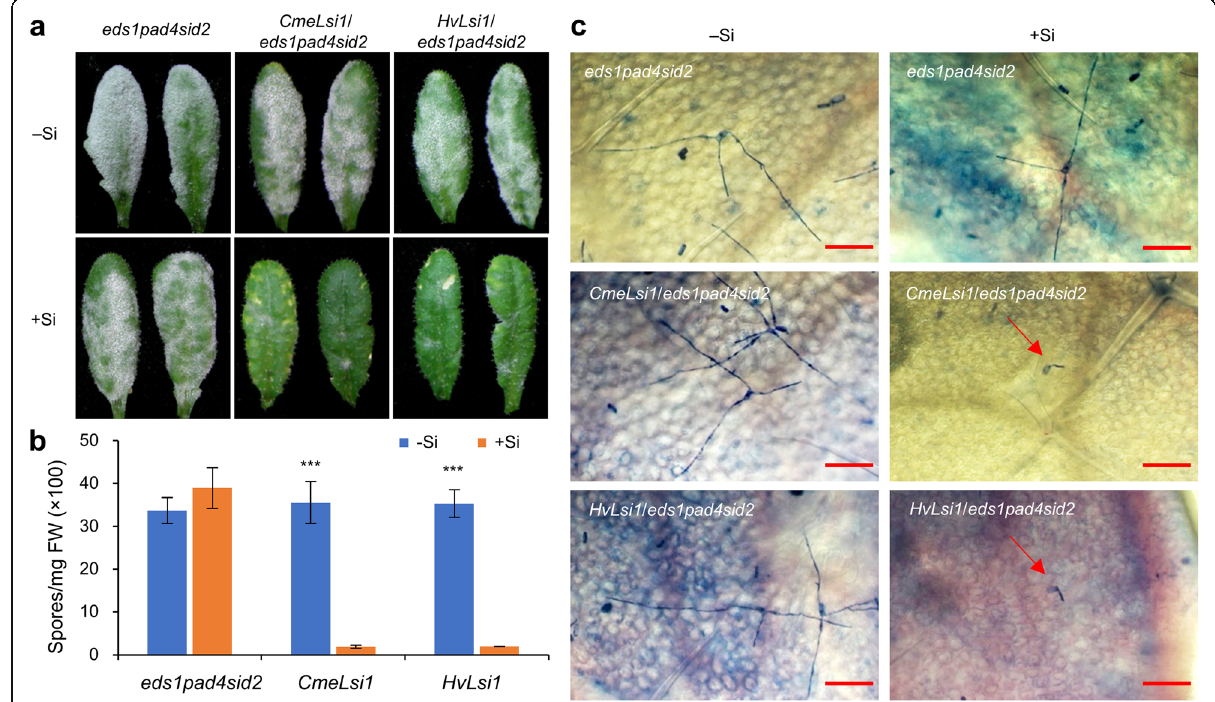
Fig. 6 High Si content reboots resistance against a non-adapted powdery mildew in an immune-compromised triple Arabidopsis mutant eds1pad4sid2 . a Representative leaves of the plants of the indicated genotypes infected with Gc UMSG1, a non-adapted powdery mildew isolate (Wen et al. 2010). The plants were grown in perlite supplemented with either 0 mM ( − Si) or 1.0 mM (+Si) Si. Pictures were taken at 10 dpi. b Quantification of spore production in the infected leaves of the plants in (a) at 10 dpi. Error bar indicates SE based on 4 replicates, and asterisks denote significant difference (Student t -test, *** P < 0.001). c Representative microscopic images showing hyphal growth of Gc UMSG1 on leaves of the inoculated plants described in (a) at 2 dpi. Red arrows point to arrested sporelings. Scale bars = 100 μ